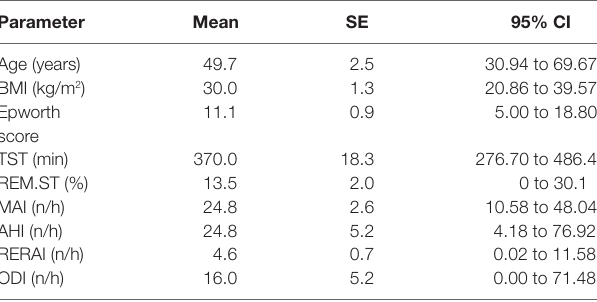
Table 1 | Clinical and polysomnographic characteristics of 25 patients.